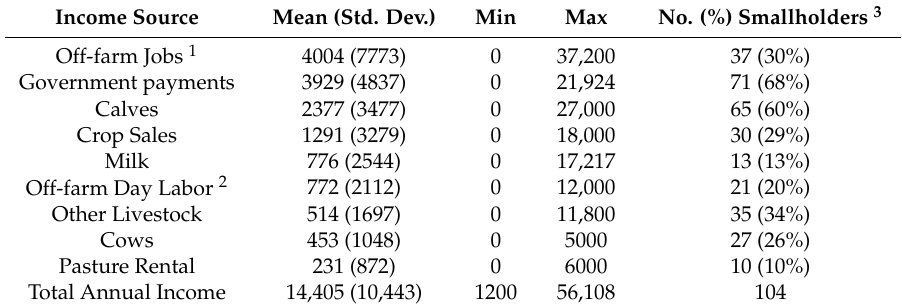
Table 5. Summary of annual income sources in 2010, in Brazilian reais (BRZ R$), at household level ( N =